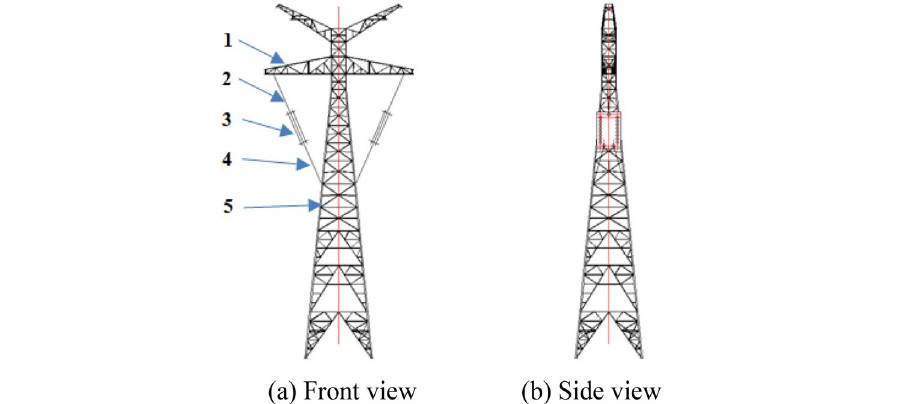
Figure 3. Layout of steel wire rope vibration reduction